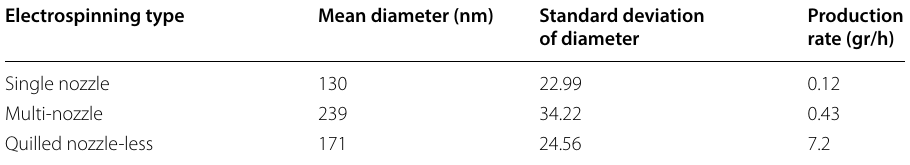
Table 2 Mean diameter and production rate of various electrospinning setup Electrospinning type